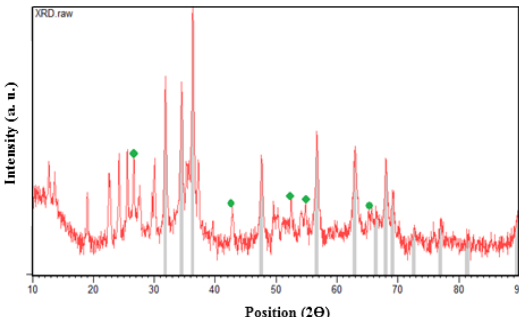
Fig. 2. The XRD patterns of the coupled ZnO/SnO 2 photocatalysts (the lines and dots show ZnO and SnO 2, respectively ).